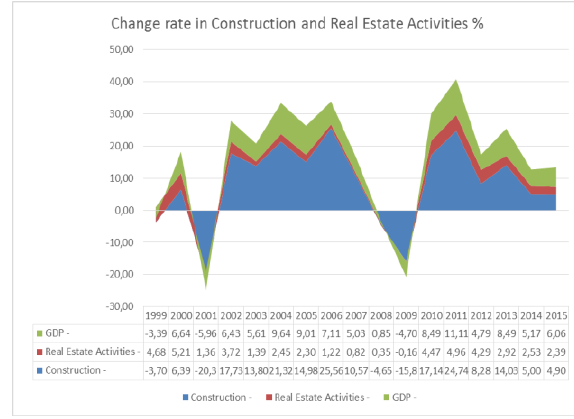
Figure 6. Change Rate in Construction Sector and Real Estate Activities